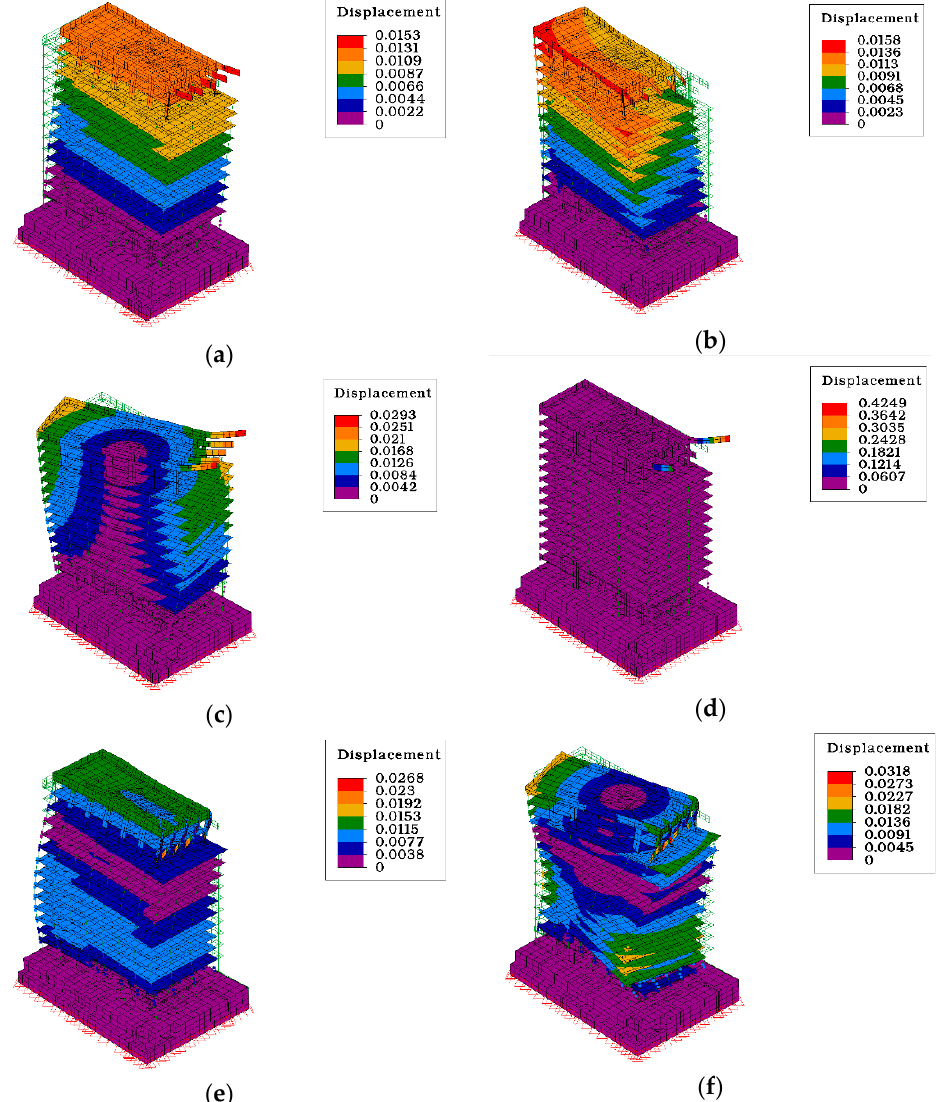
Figure 19. Mode shapes of natural vibrations for frequencies: ( a ) f 1 = 0.8431 Hz; ( b ) f 2 = 1.3476 Hz; ( c ) f 3 = 1.4488 Hz; ( d ) f 5 = 2.5222 Hz; ( e ) f 9 = 4.0457 Hz; ( f ) f 10 = 4.3516 Hz. ( d ) f 5 = 2.5222 Hz; ( e ) f 9 = 4.0457 Hz; ( f ) f 10 = 4.3516